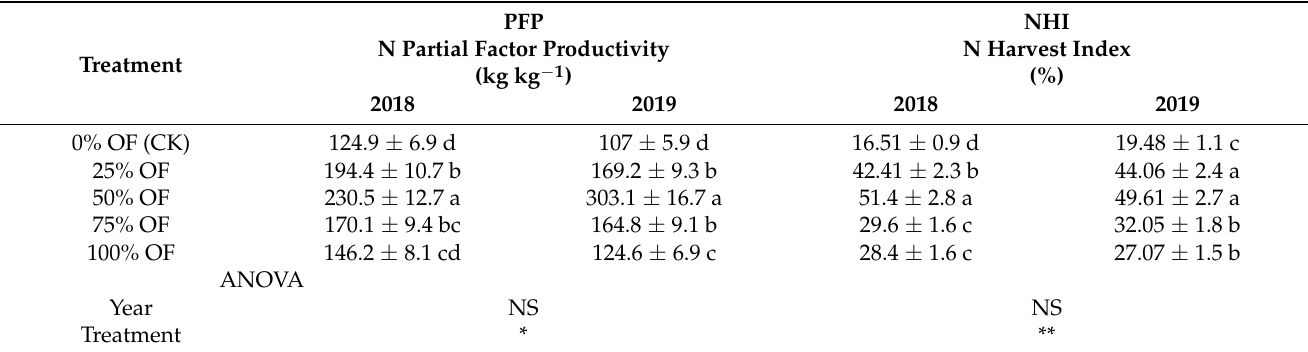
Table 8. Dynamic change of N efficiency for different